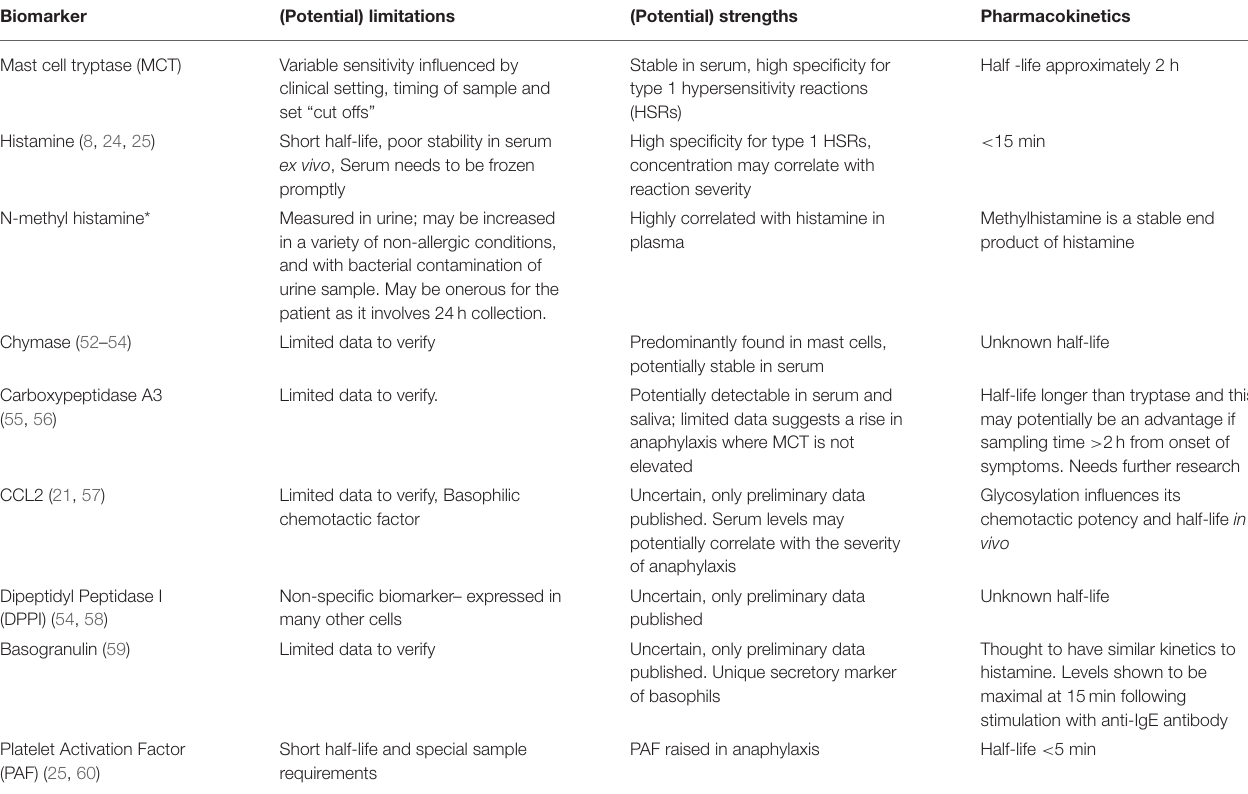
TABLE 2 | Summary of existing and new biomarkers in anaphylaxis, their (potential) limitations, strengths, and